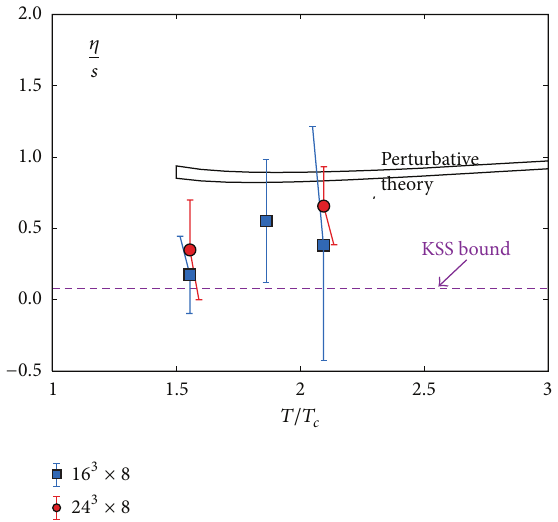
Figure 4: Viscosity over entropy ratio (𝜂/𝑠) as a function of temperature from perturbative calculation [62, 63], lattice QCD calculation [64]. AdS/CFT bound 𝜂/𝑠 = 1/4𝜋 is also